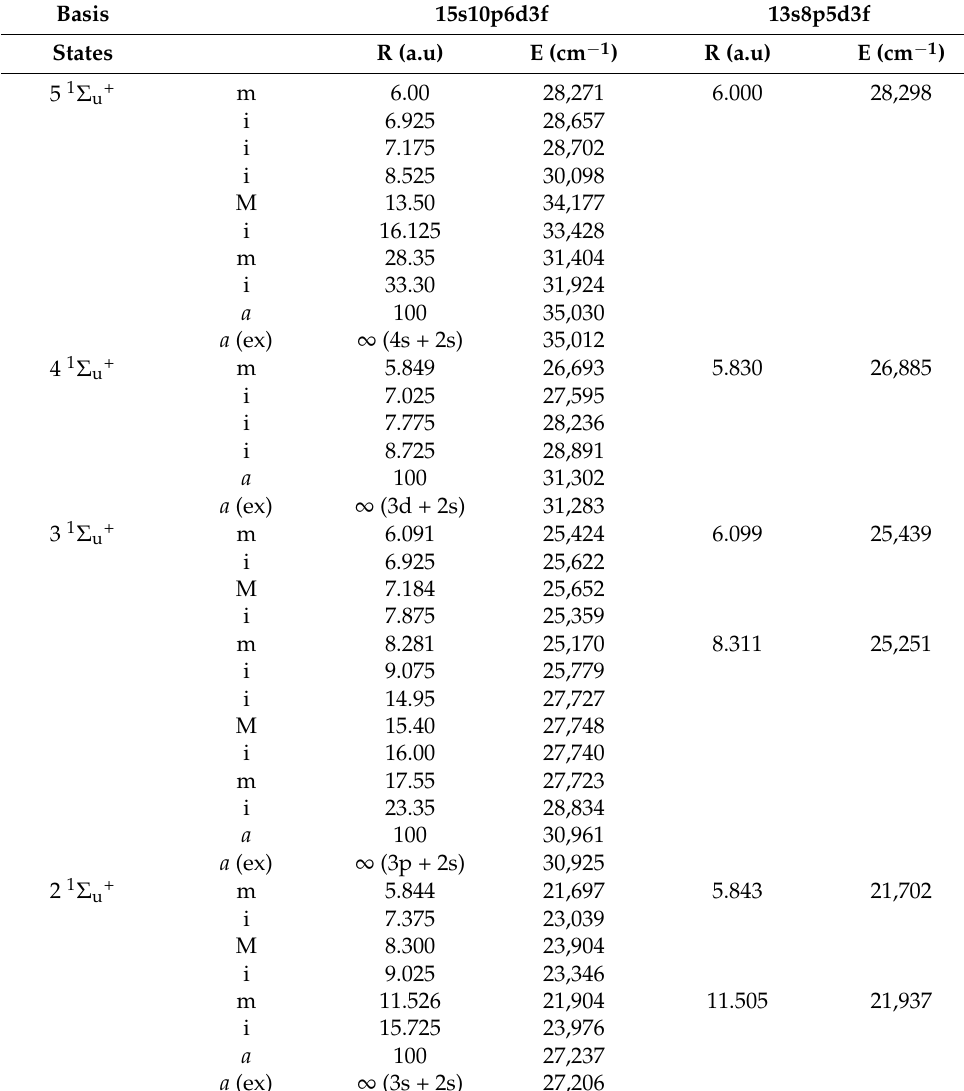
Table 1. Critical points (maxima M, minima m, inflection i, asymptote a), of the electronic states calculated in this work.